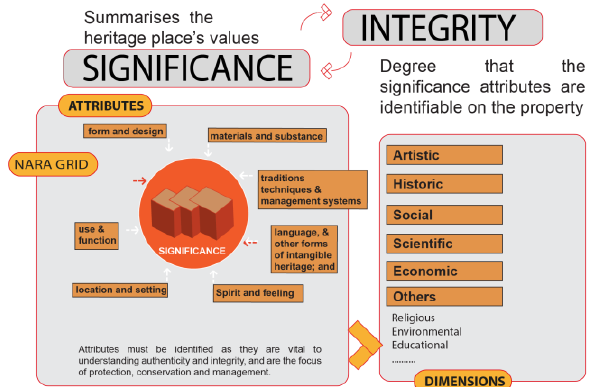
Figure 5: Nara Grid